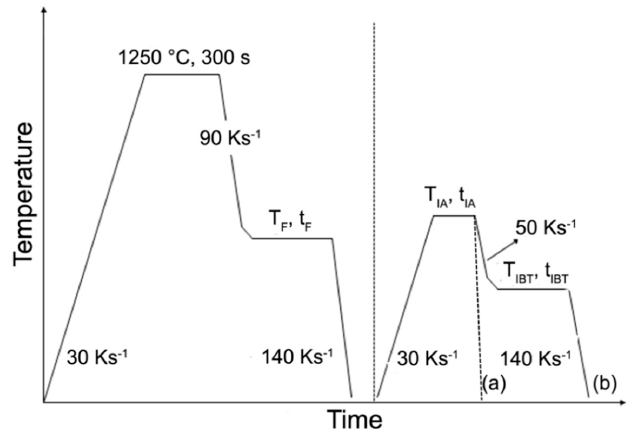
Figure 3. Schemes of processing schedules applied to simulate the production of ( a ) Dual Phase